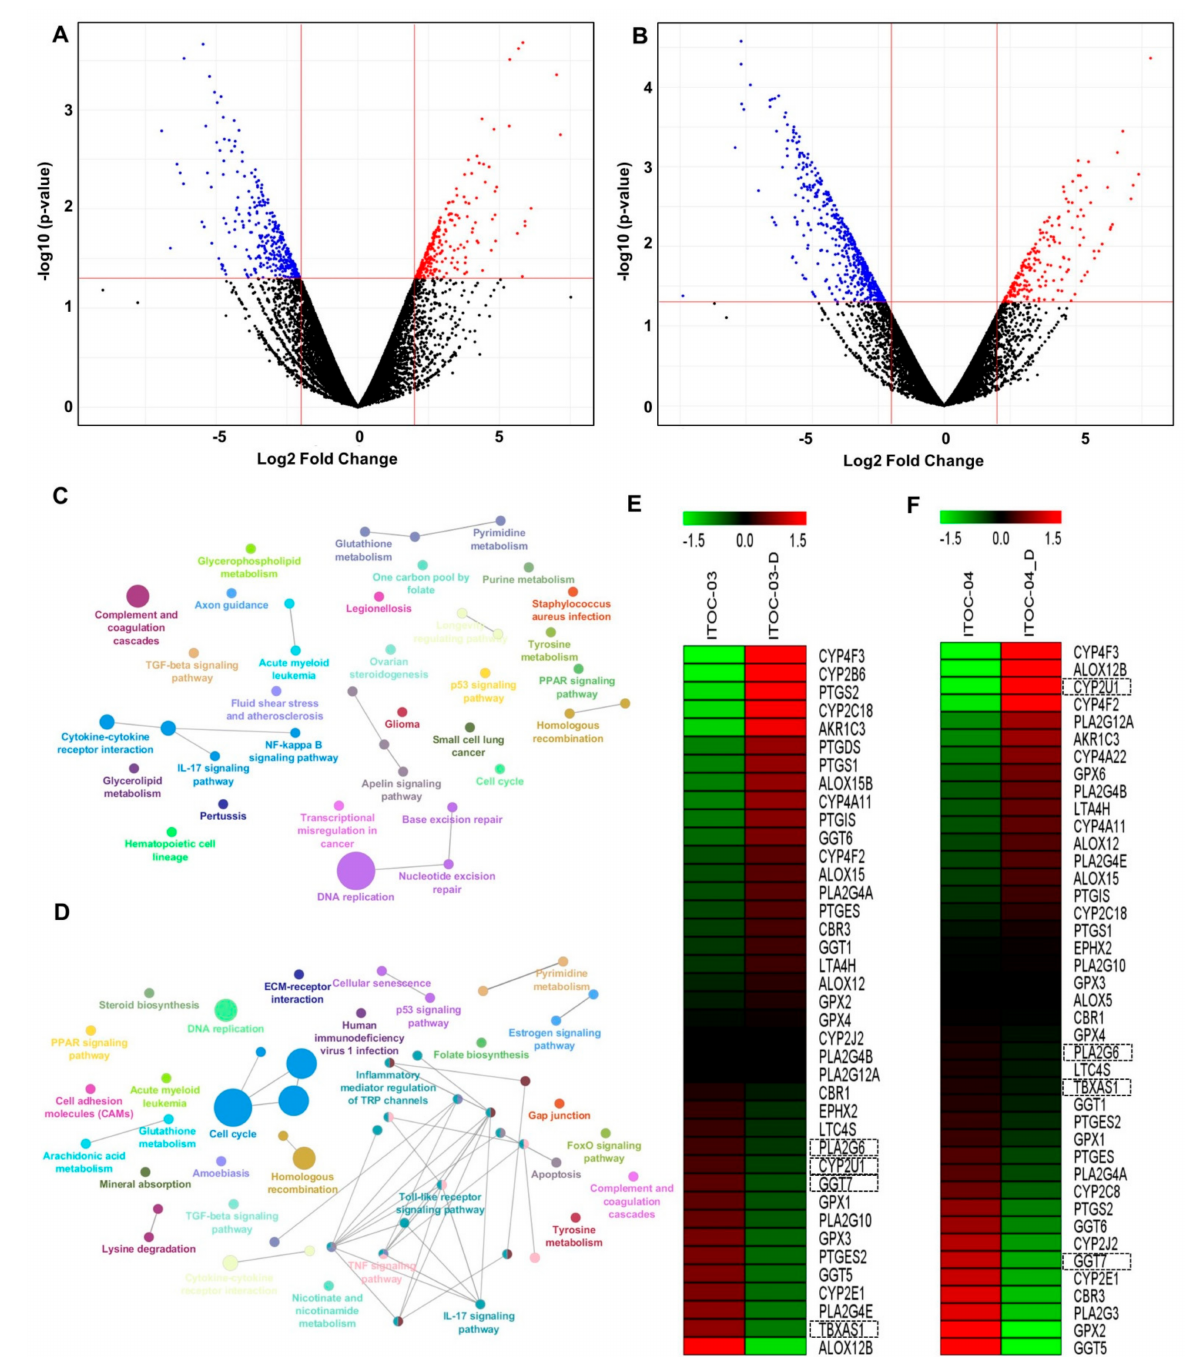
Figure 3. Differential gene expression and pathway enrichment of aspirin-treated GB-SCC cells. ( A , B ) Volcano plot highlighting significantly altered genes in aspirin-treated ITOC-03 and ITOC-04 cells, respectively. The scattered points on the plot represent genes. Blue dots denote down-regulated genes, red dots denote up-regulated genes, and black dots denote no significant change in gene expression on treatment with aspirin. Pathway enrichment analysis for aspirin-treated ( C ) ITOC-03 and ( D ) ITOC-04 cells using the ClueGO plugin in the cytoscape tool. Enriched pathways are displayed as nodes with different colors and only the most significant in the group are labelled. Multi-color nodes depict